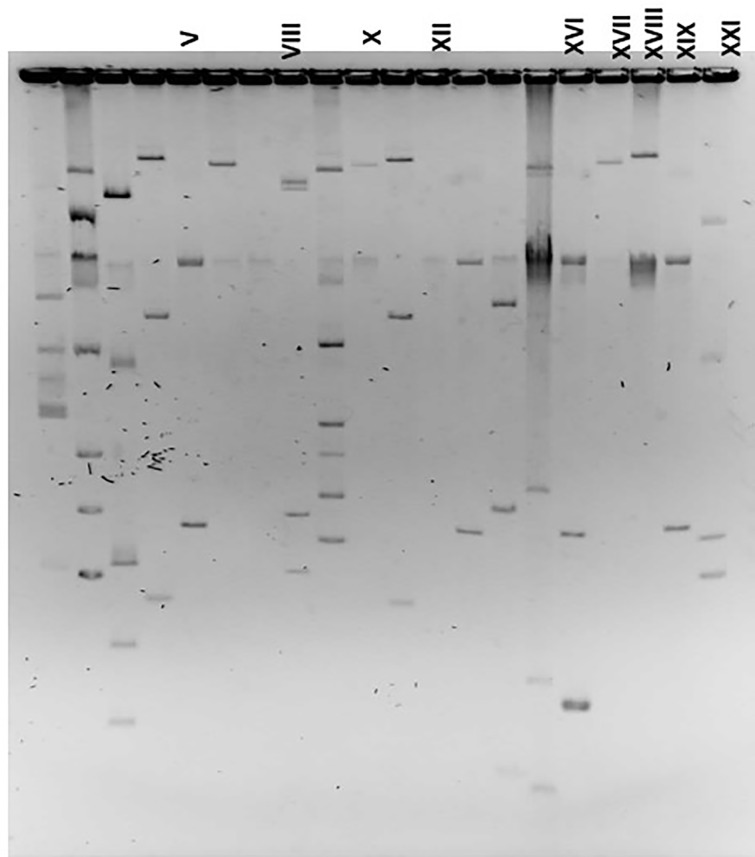
Plasmid profiles of Acinetobacter strains.Lanes marked with roman numerals are plasmid profiles isolated from Acinetobacter baumannii. Unmarked lanes are plasmid profiles of other Acinetobacter species isolated during this study period. Plasmid profile (strain number): V (2161), VIII (2339), X (3108), XII (3496), XIII (5189), XVI (4197), XVII (6793), XVIII (2275), XIX (2663), XXI (3275).